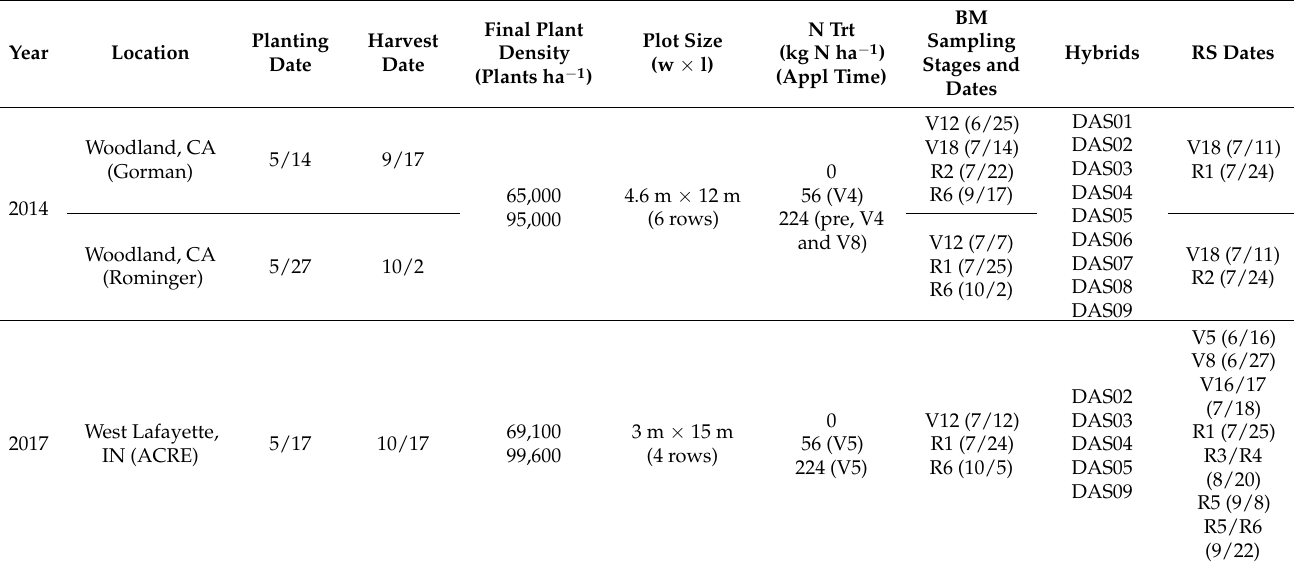
Table 1. Experiment design with sampling and imaging